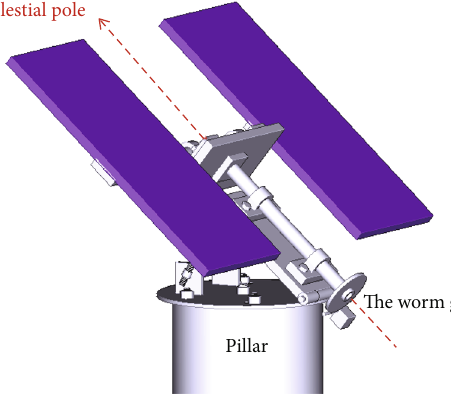
Figure 23: The motorization of the tracking